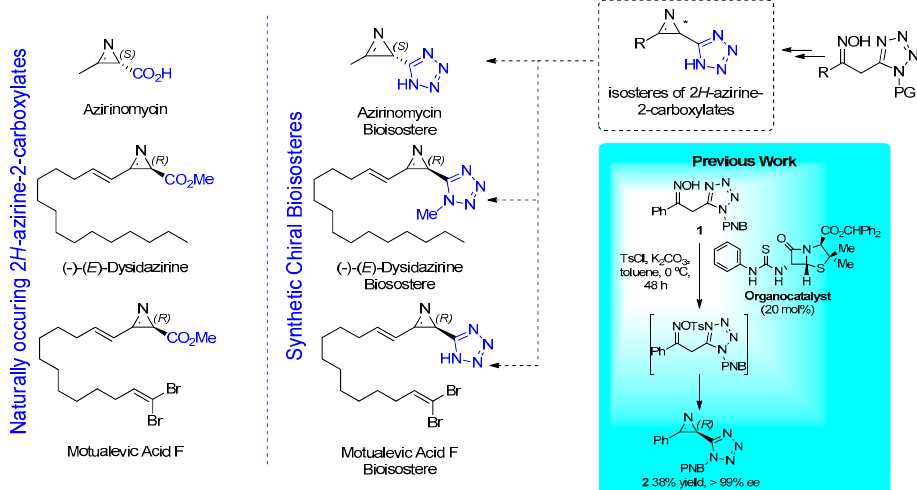
Figure 1. Natural occurring and new chiral 2-(tetrazol-5-yl)-2 H -azirine Figure 9. Natural occurring and new chiral 2-(tetrazol-5-yl)-2 H -azirine bioisosteres.